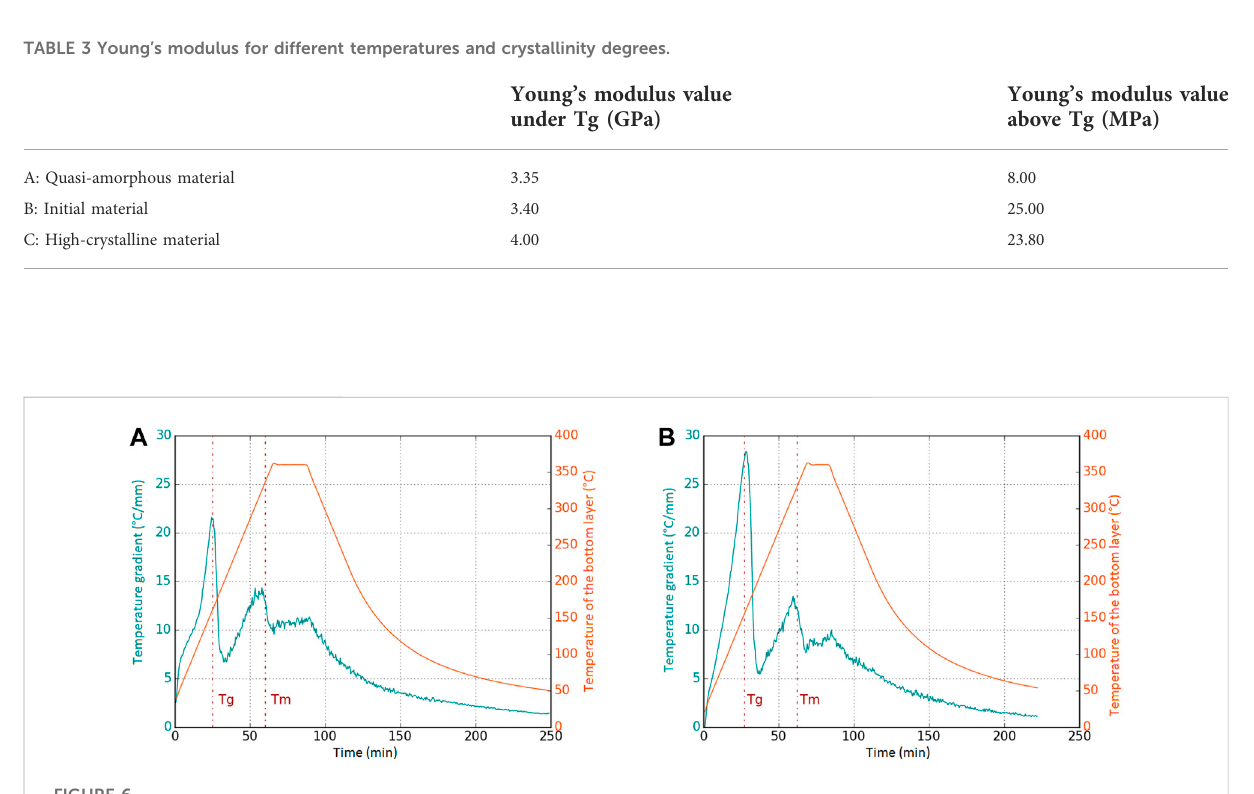
TABLE 3 Young ’ s modulus for different temperatures and crystallinity degrees.